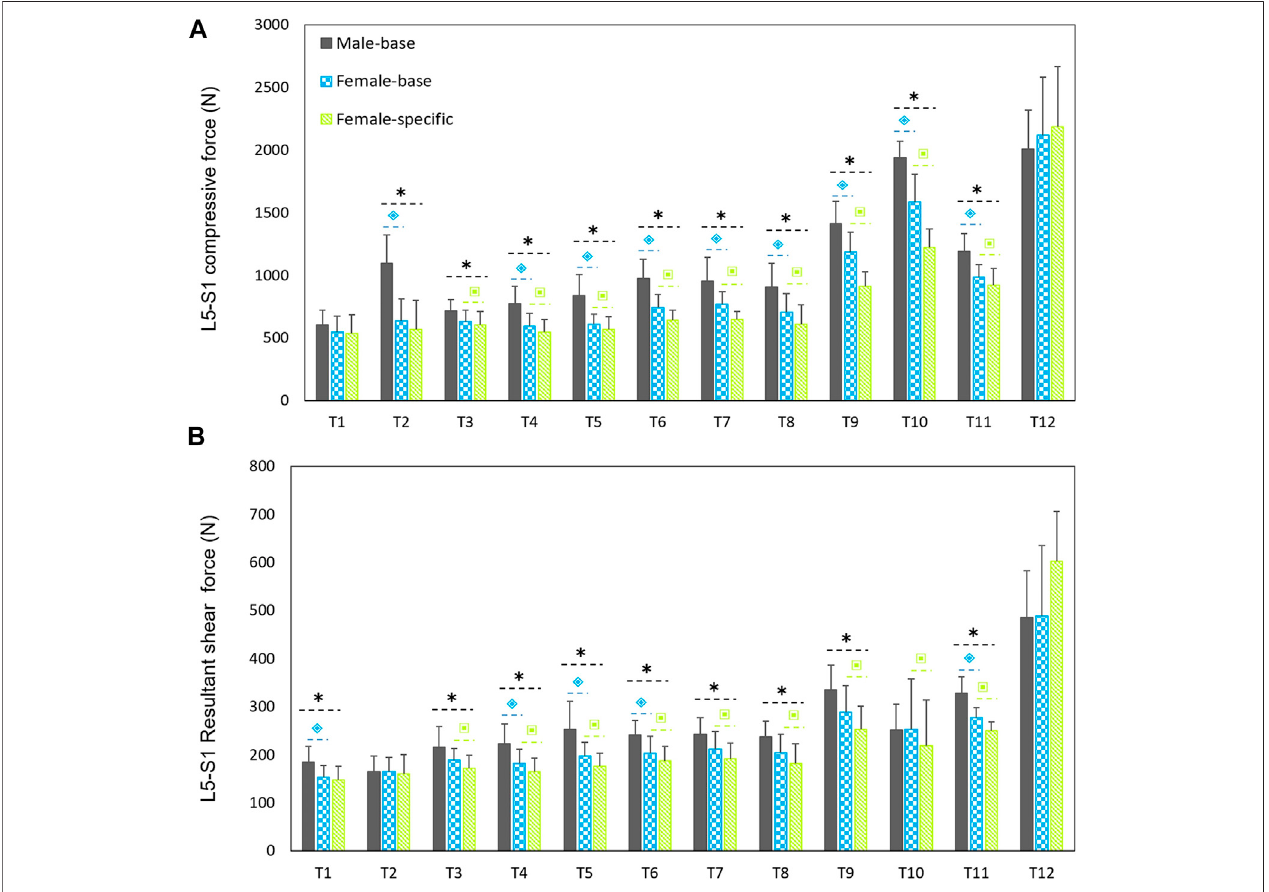
FIGURE 3 | Predicted mean (standard deviations as error bars) absolute L5-S1 compressive (A) and shear (B) forces by the base-models for both sexes and female-speci fi c models for females. ⌺ indicates a signi fi cant difference ( p < 0.05) between males and females load predicted by base-models. * indicates a signi fi cant difference ( p < 0.05) between loads predicted by male models and female-speci fi c models. ⌺ indicates a signi fi cant difference ( p < 0.05) between loads predicted by female-base models and female-speci fi c